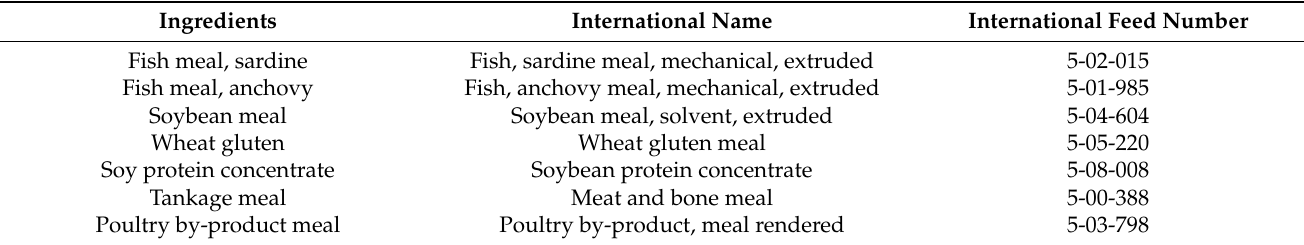
Table 2. International names of the protein sources used in this